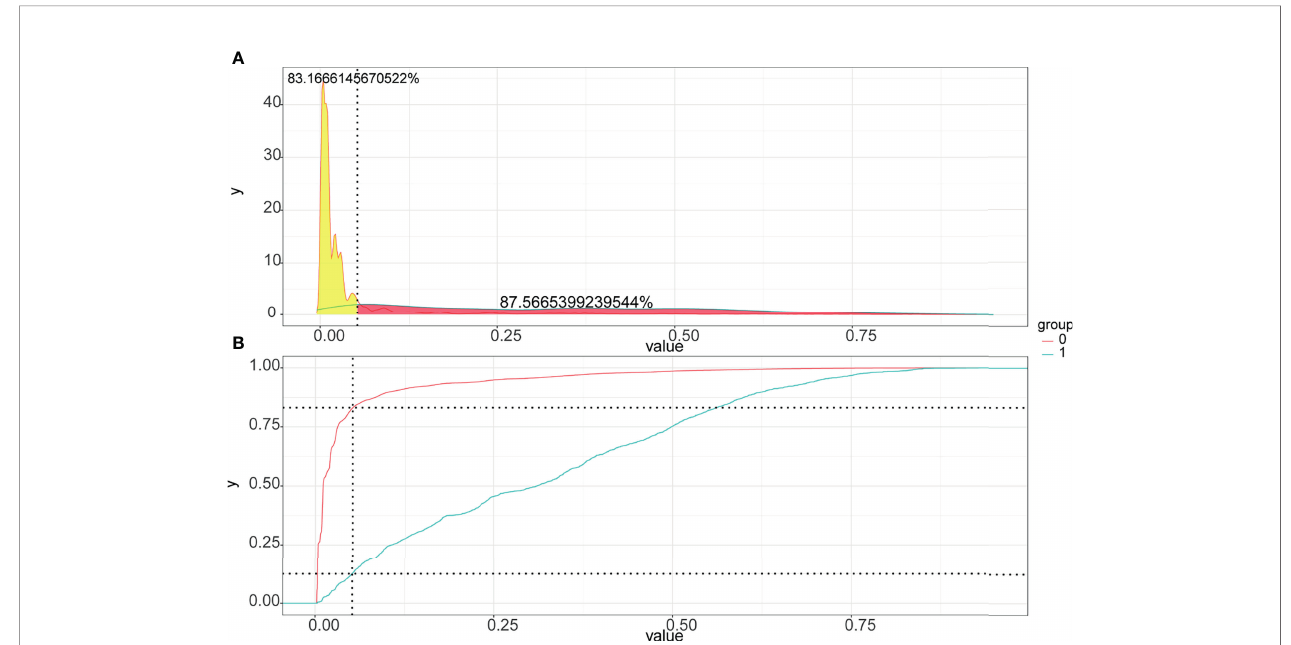
FIGURE 5 | Probability density function graph (A) and Clinical utility curve (B) of the